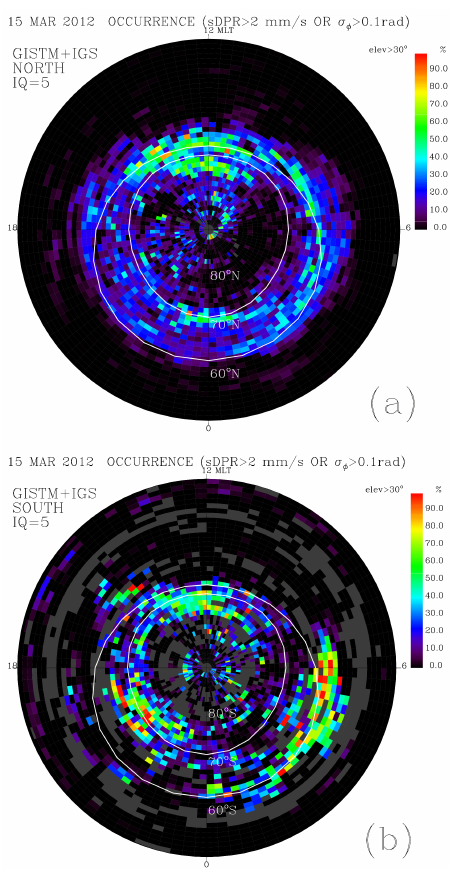
Figure 9. The composite maps of phase scintillation combining the occurrence of sDPR>2mms − 1 and σ (cid:56) >0.1rad in the (a) northern and (b) southern high latitudes on 16